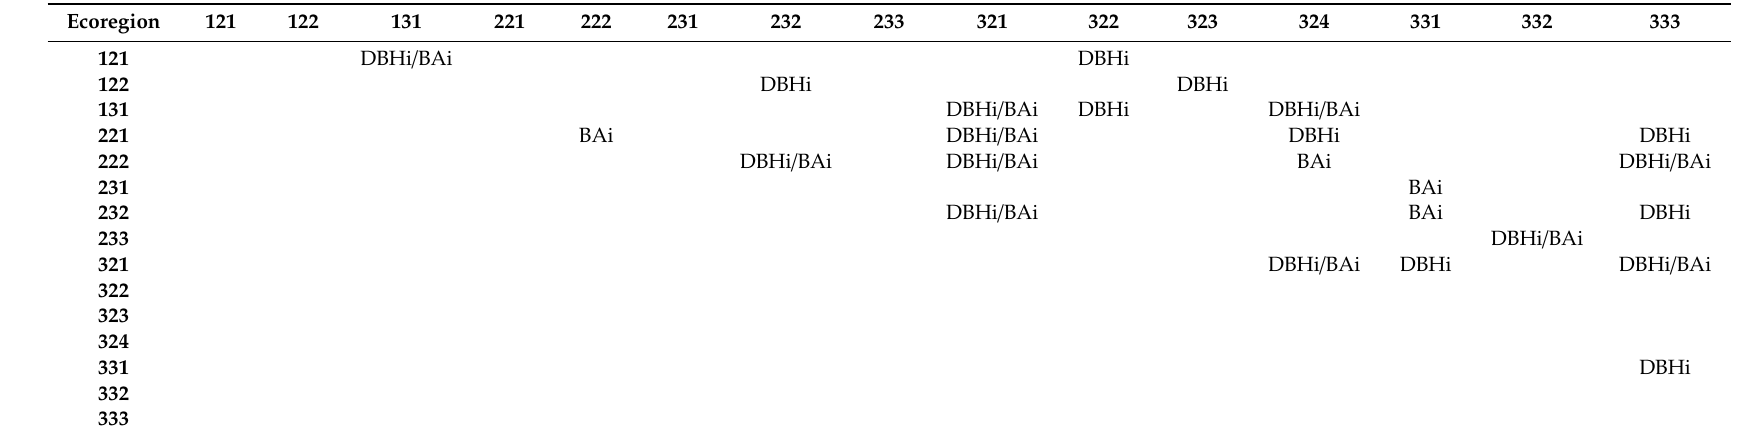
Table 5. Impact on growth of European beech by ecoregions assessed with the estimated marginal means. Ecoregions not significantly di ff erent are identified for DBH increment and basal area increment with DBHi or BAi, respectively. The empty cells indicate significant di ff